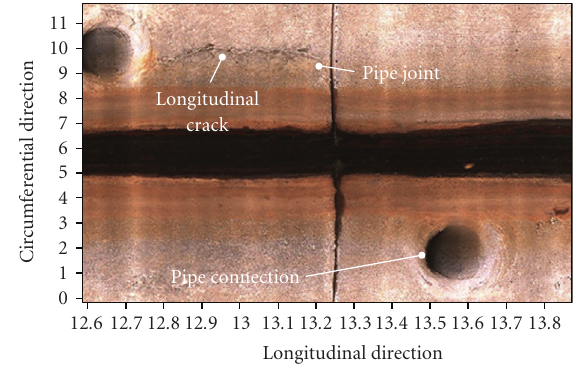
Figure 3: A section of an unwrapped pipe image.